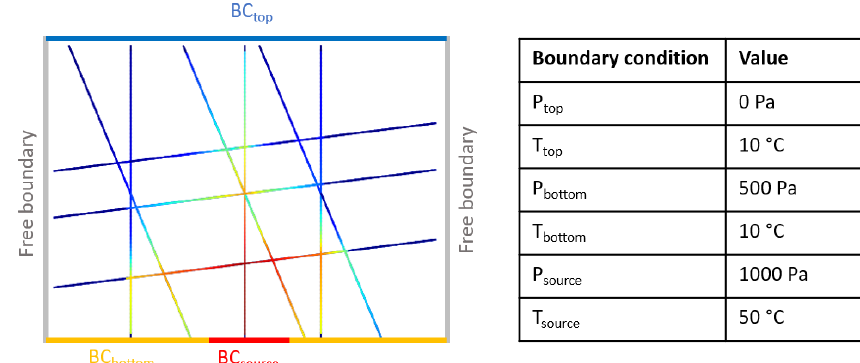
Figure 3. Boundary conditions of the forward modelling.